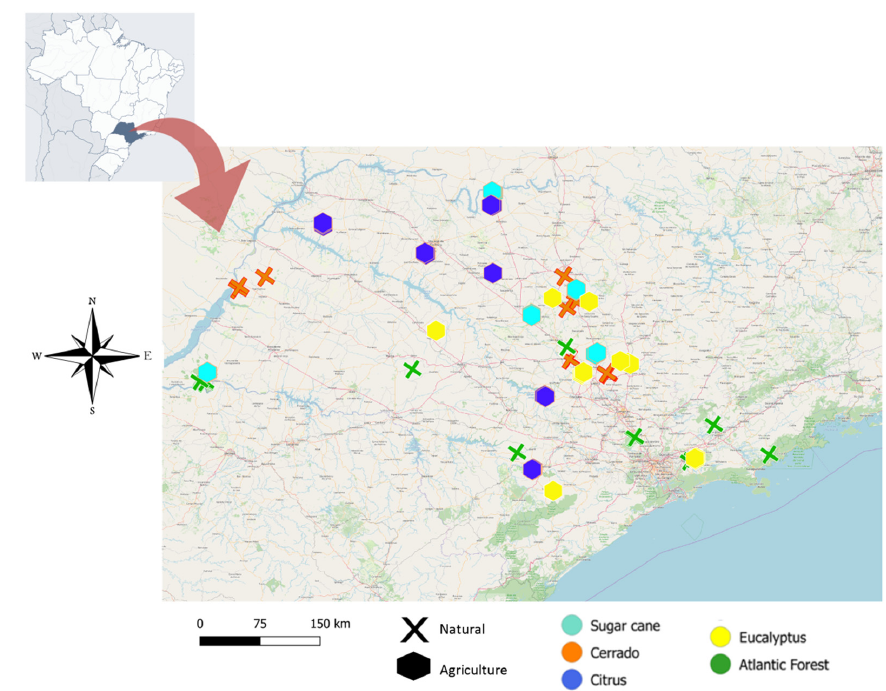
ff erent natural and agricultural